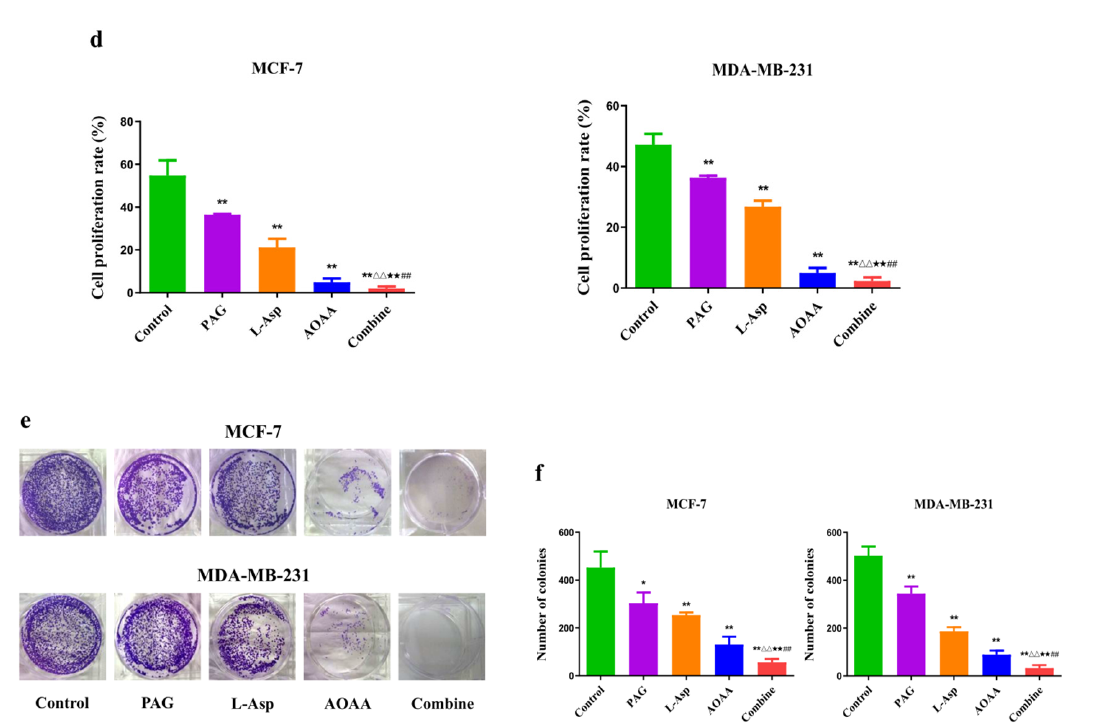
Figure 1. Effects of PAG, AOAA, and L-Asp on viability, H 2 S content, proliferation, and colony formation in human BC cells. ( a ) The CC-K8 assay was used to determine the percentage of viable cells. The cell viability of each group without PAG, AOAA, or L-Asp treatment was normalized as 100% and considered to be the control group. ( b ) The levels of H 2 S in BC cells were detected. ( c ) The proliferation rate of each group was analyzed. ( d ) DNA replication activities of BC cells in each group were examined by EdU assay (original magnification × 200). ( e ) The clonogenic capacity was determined in BC cells. ( f ) The number of colonies was calculated. The experiments were performed in triplicate. Data are presented as mean ± SEM. * p < 0.05, ** p < 0.01 compared with the control group; △△ p < 0.01 compared with PAG group; ★★ p < 0.01 compared with AOAA group; ## p < 0.01 compared with L ‐ Asp group.